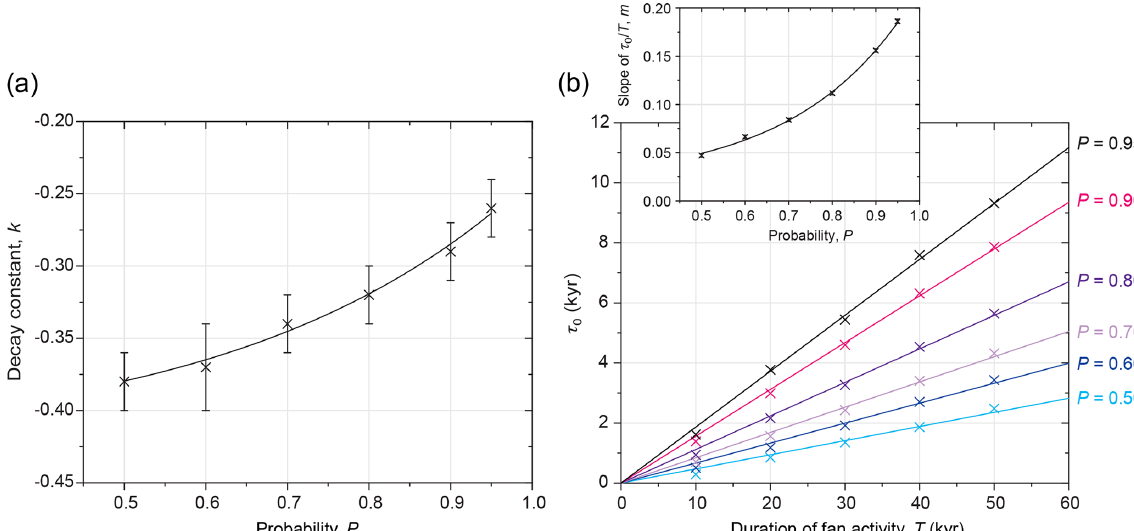
Figure 5. (a) Variation in the decay constant, k , as a function of the probability, P . Error bars show the standard error in k when Eq. (2) is fitted to the data in Fig. 4. The regression corresponds to Eq. (3). (b) Variation in τ 0 as a function of T for different values of P (indicated by colours). Linear regressions are fitted corresponding to Eq. (4). Inset: variation in m as a function of P . An exponential regression is fitted corresponding to Eq.